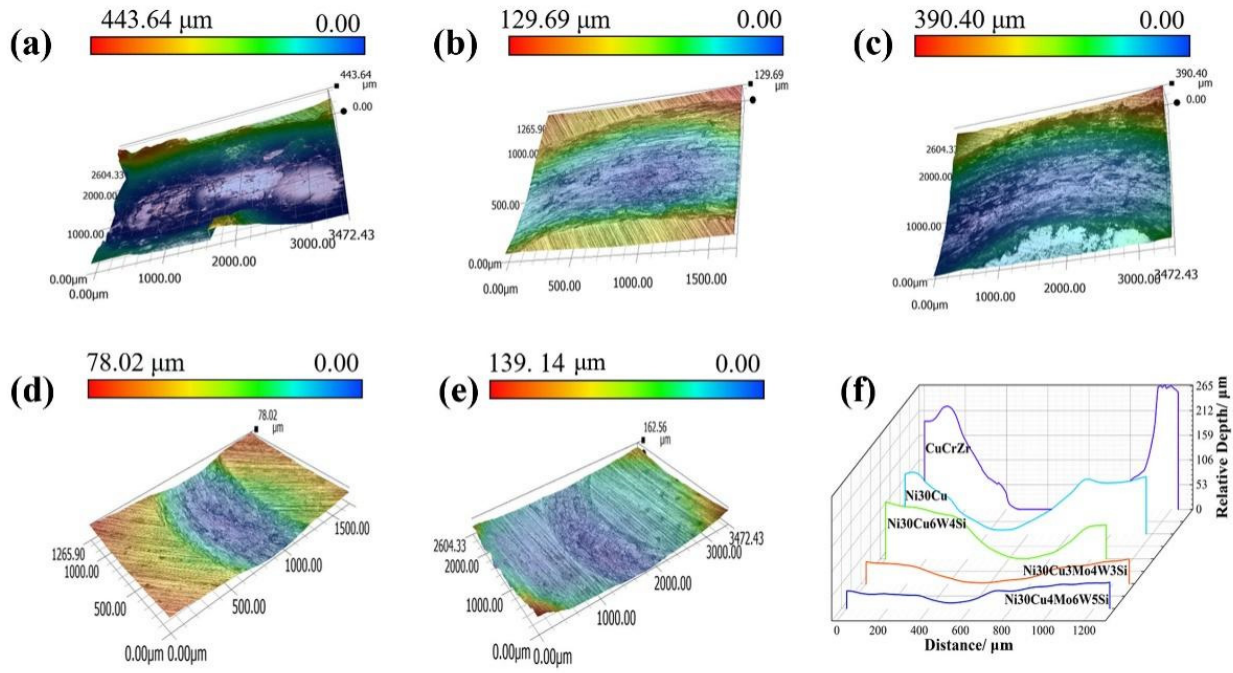
Figure 10. Wear surface morphology: ( a ) Cu–Cr–Zr substrate; ( b ) Ni–Cu coating; ( c ) Ni–Cu–10(W,Si) coating; ( d ) Ni–Cu–10(Mo,W,Si) coating; ( e ) Ni–Cu–15(Mo,W,Si) coating; ( f ) profile of the wear scar section.